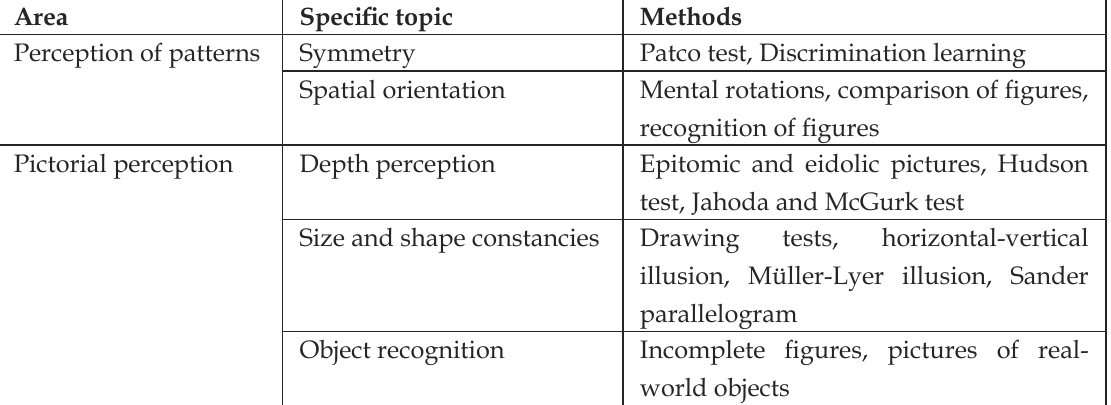
Tab. 1. The areas of cross-cultural research on